Question: Provide a publication-style caption for this figure.
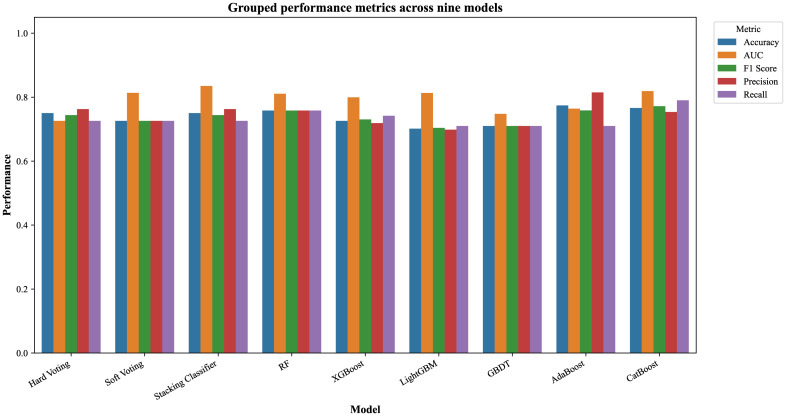
Answer: Comparative visualization of model performance metrics.